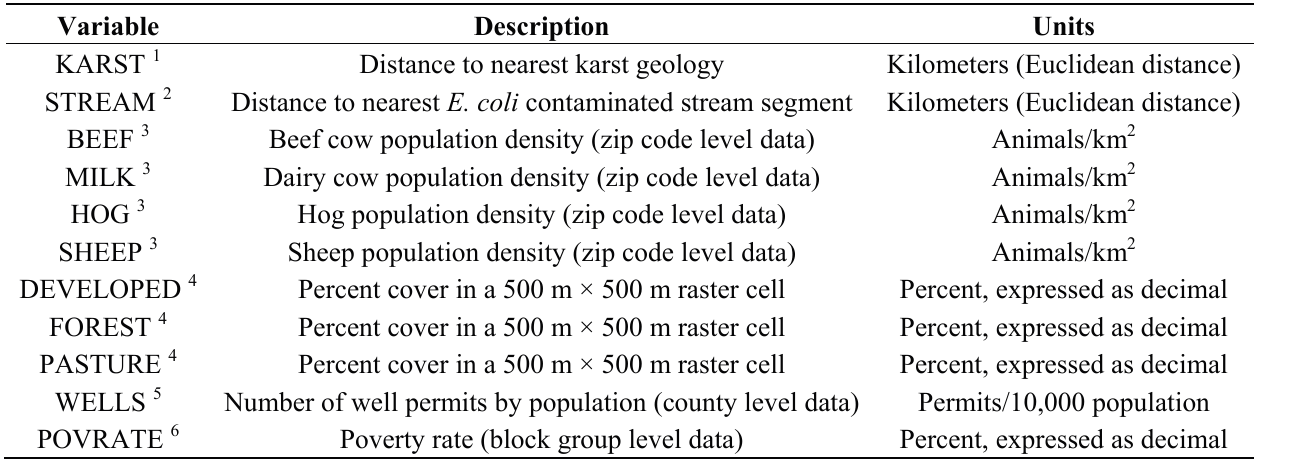
Table 1. Candidate explanatory variables for cryptosporidiosis and E. coli O157 infection.